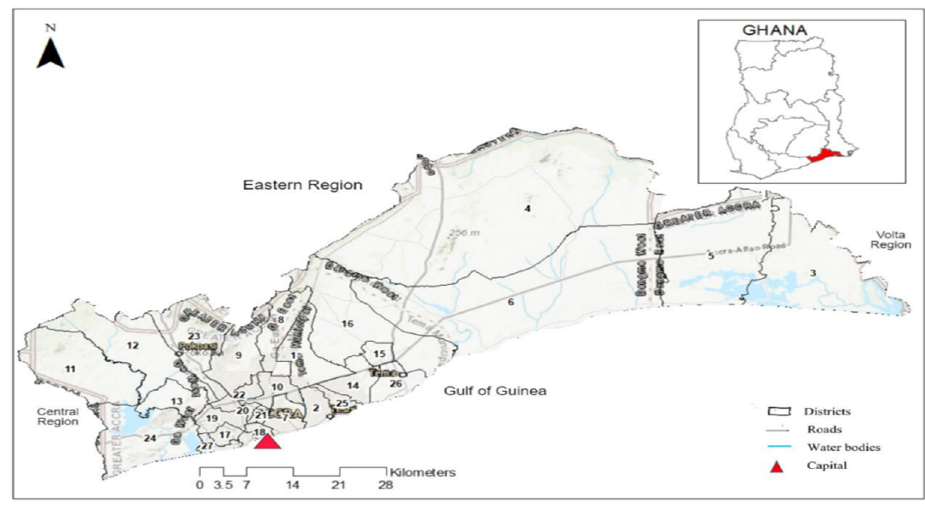
Figure 1. Map of Greater Accra Region with 29 districts and neighboring regions, roads, water bodies, and regional capital. Source: Authors’ own contribution.